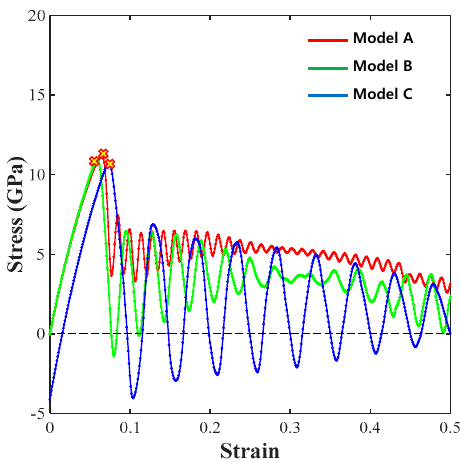
Figure 8. Z-direction σ – ε results for models A, B, and C.